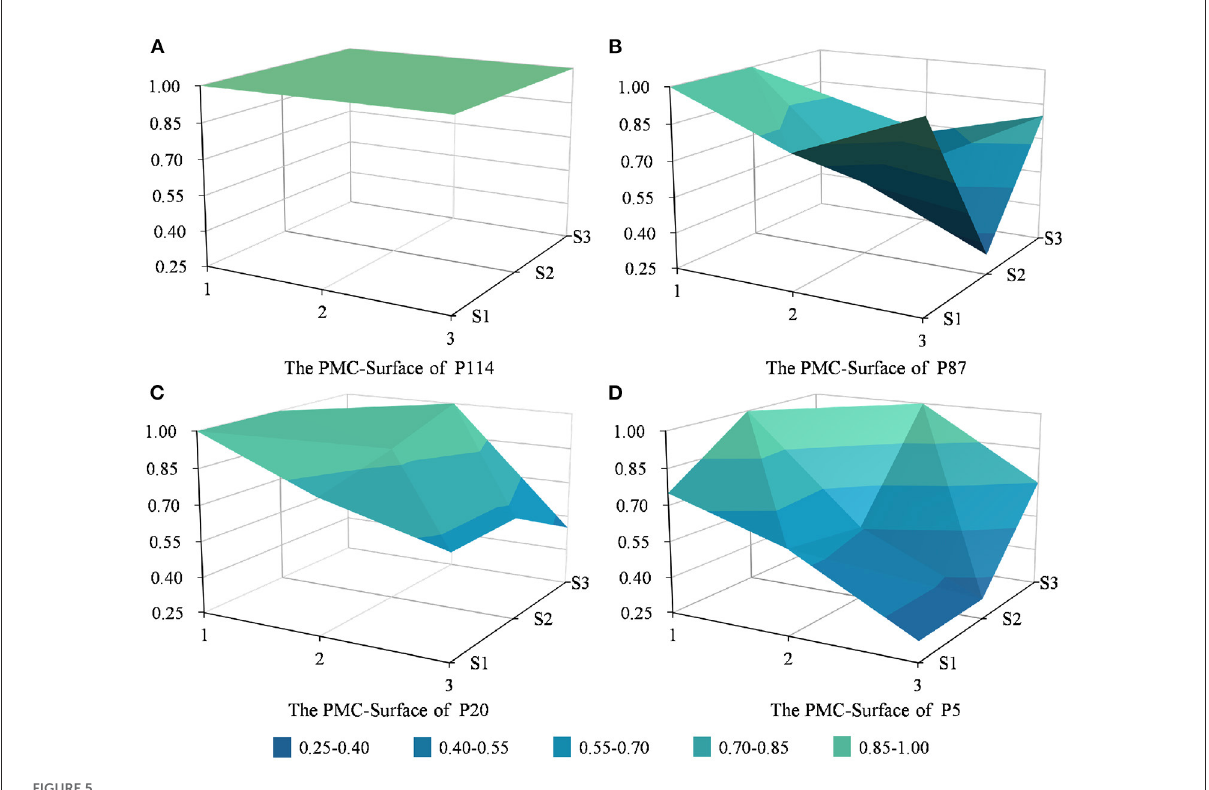
FIGURE5 PMC surface charts of P114, P87, P20, and